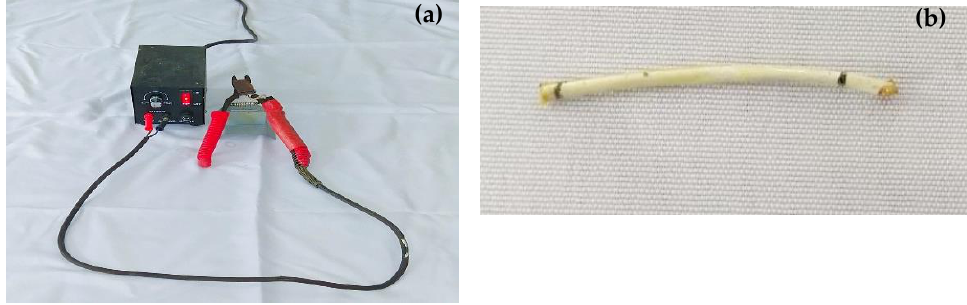
Figure 2. Encapsulation equipment: ( a ) hot scissors equipped with a battery, ( b ) sample of healing fiber.